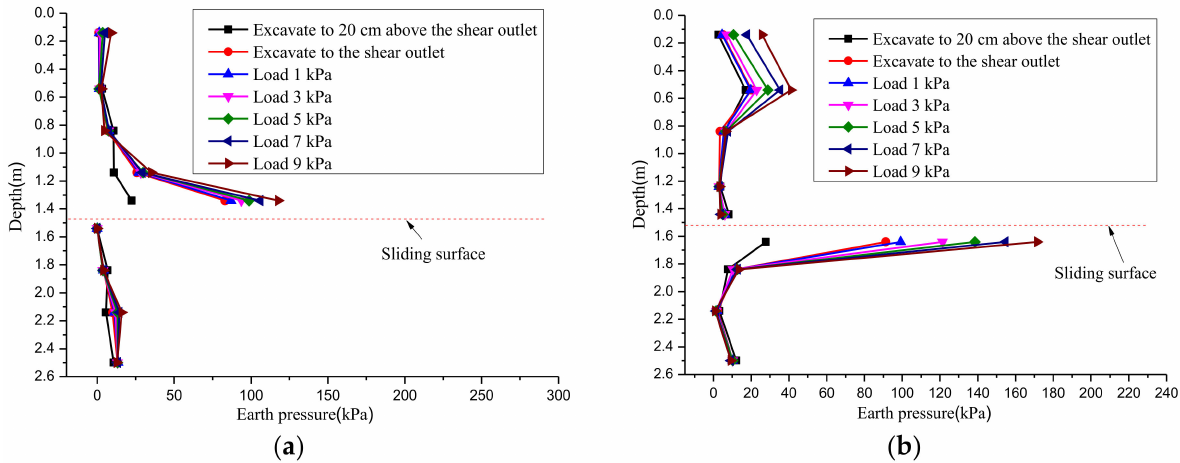
Figure 13. Earth pressure distribution curve of pile no. 4: ( a ) earth pressure distribution curve in front of the pile; ( b ) earth pressure distribution curve behind the pile.